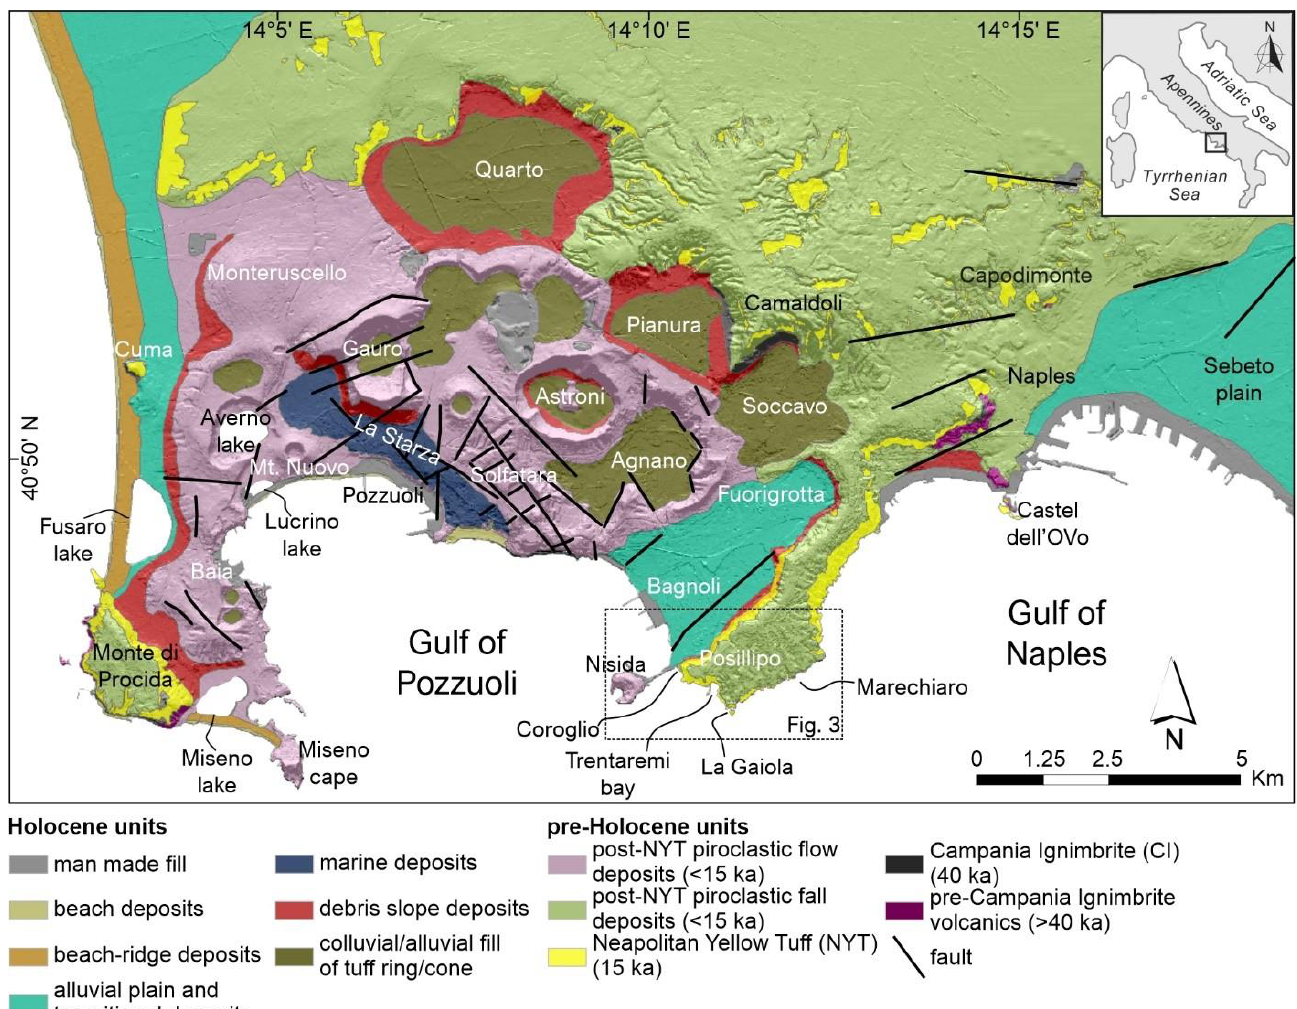
Figure 1. Geolithological map of the Campi Flegrei (modified from [10]). Faults are derived from the Geological Sheet 447—Napoli of the Geological Map of Italy at scale 1:50,000, CARG Project [35]. Dashed rectangle indicates location of the Coroglio-Trentaremi sea cliff shown in Figure 3.